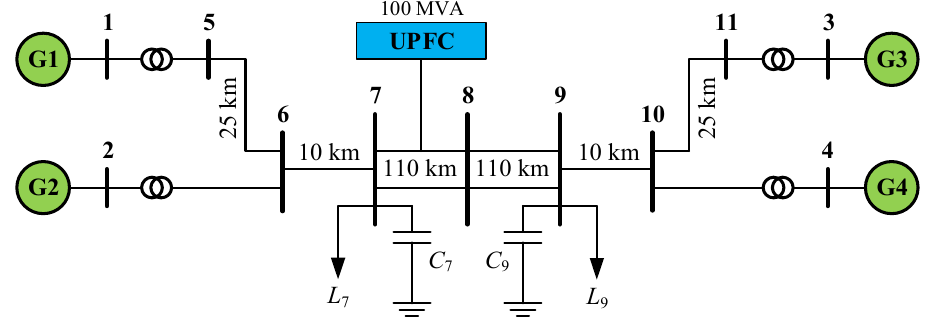
Figure 9. Estimation of ATWs for series-shunt-compensated systems for faults after UPFC. ( a – d ) Estimated ATWs for Scenario 3. ( e – h ) Estimated ATWs for Scenario 4. ( i – l ) Estimated ATWs for Scenario 5.